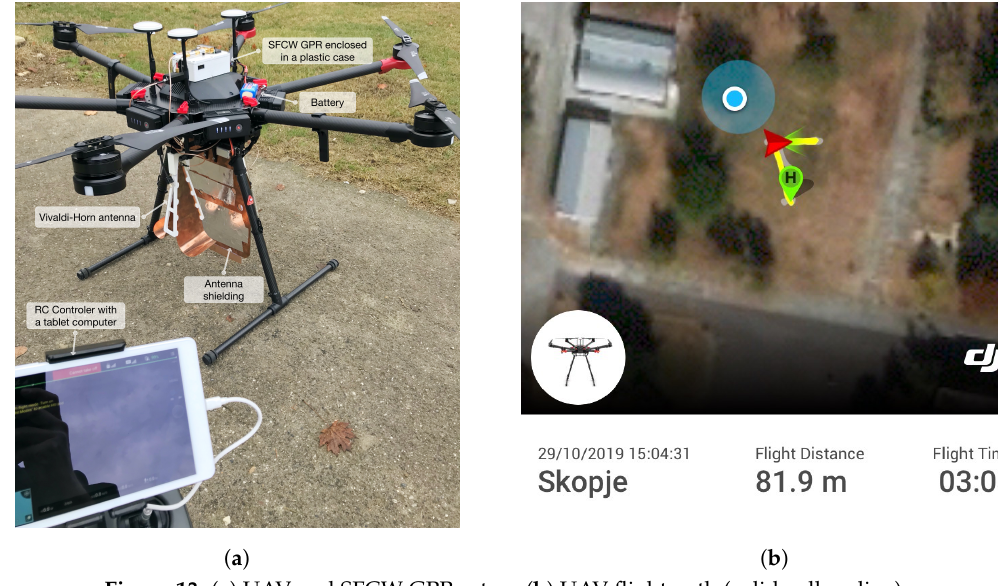
Figure 13. ( a ) UAV and SFCW GPR setup; ( b ) UAV flight path (solid yellow line).